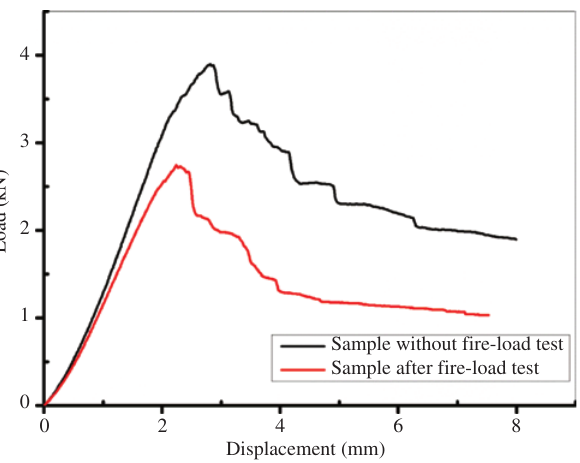
Figure 11: The typical load-displacement curves for lattice reinforce- ment sandwich structure between the sample without fire load and after fire